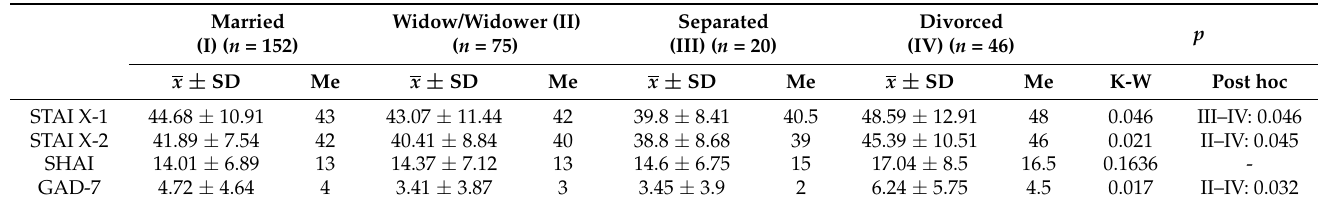
( p = 0.032) (Table 5). Table 5. Impact of marital status on the scores obtained in the psychometric scales applied in the study *. Married Widow/Widower (II) (I) ( n = 152) ( n = 75)